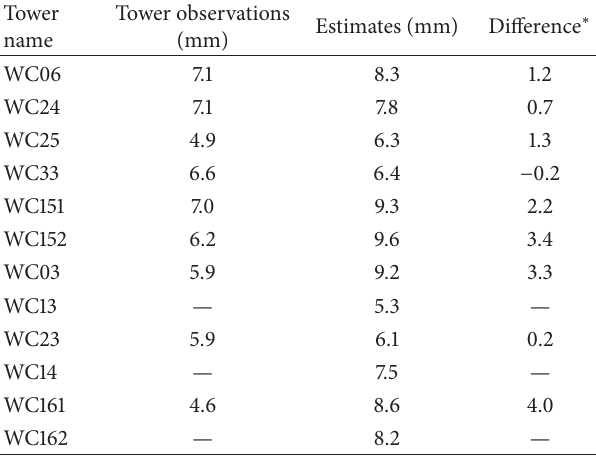
Table 4: Comparison between the observed daily ET and the extrapolated daily ET from Landsat-based